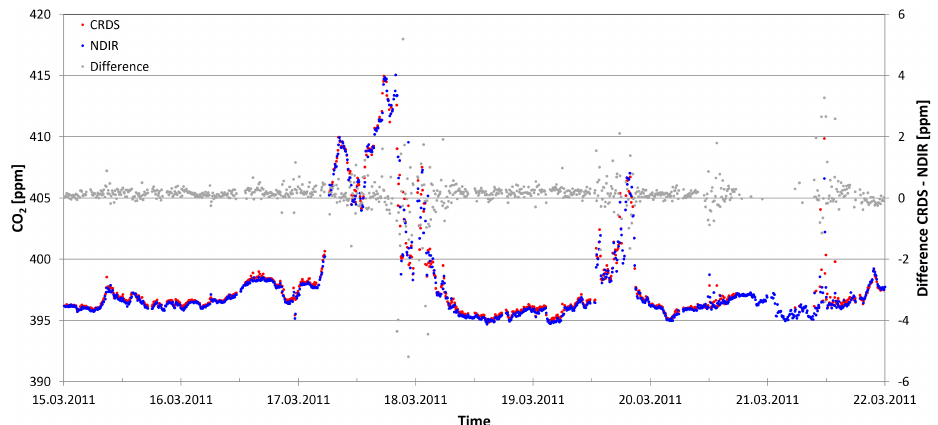
Figure 5. Time series of 115s averaged CO 2 mole fractions measured with CRDS (red) and NDIR (blue) at JFJ (left-hand y axis scale) and the difference between the two systems against time (grey points) (right-hand y axis scale) for 1 week in March